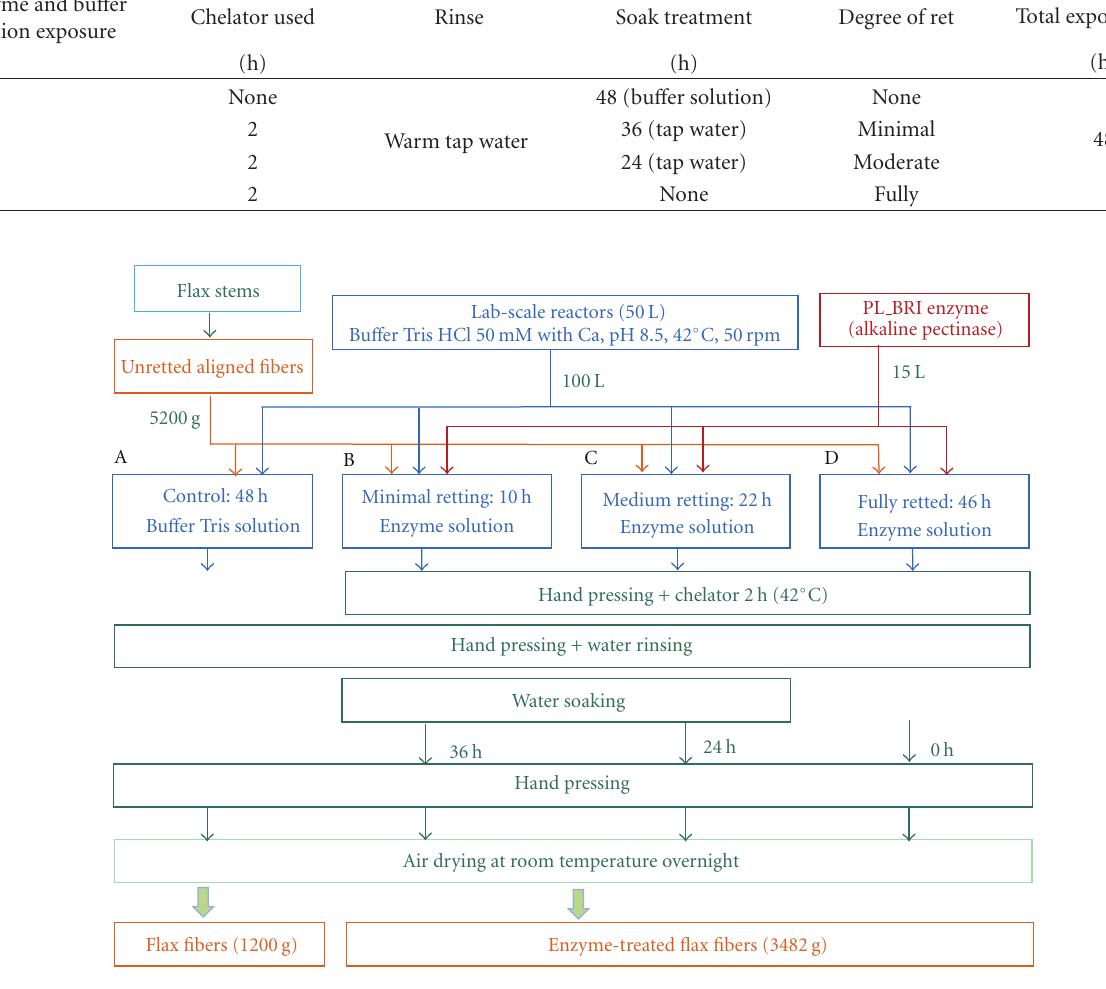
Figure 1: Enzyme treatment